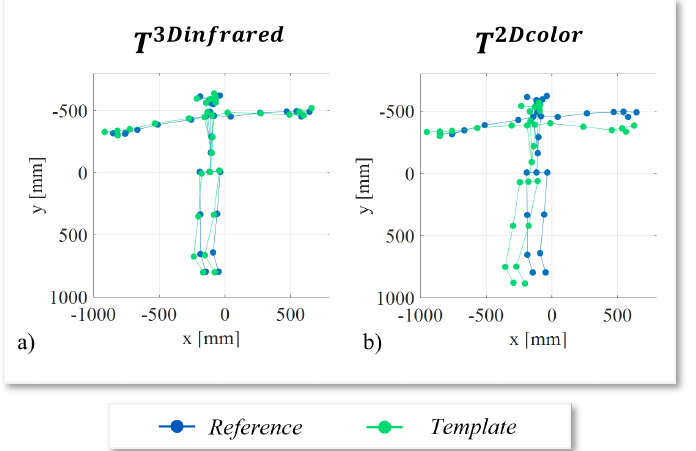
Figure 11. Graphic representation of the ( a ) best ( T 3 Dinfrared ) and ( b ) ( T 2 Dcolor ) worst skeleton alignments. In both graphs, the aligned template skeleton is in green, while the reference skeleton is in